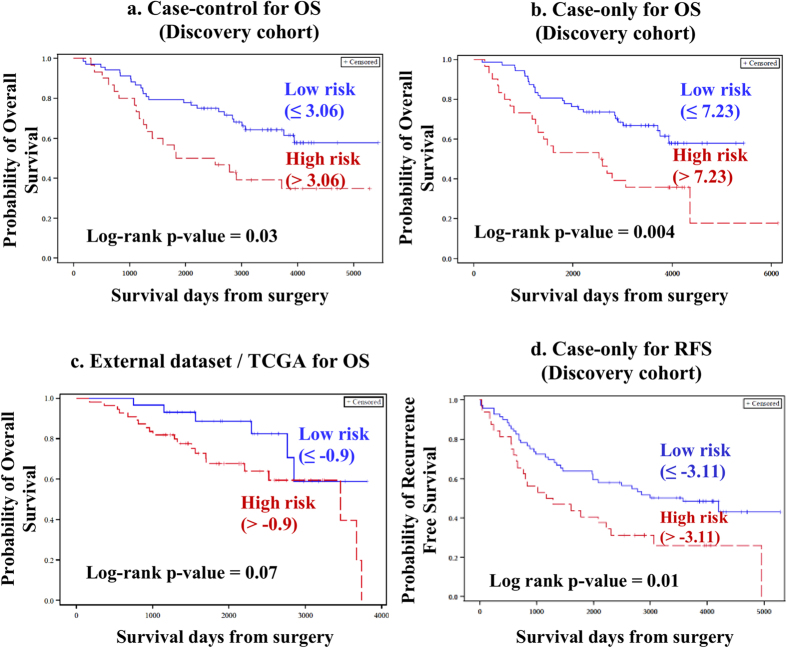
Kaplan-Meier plots for Overall Survival.Probability of OS is plotted over time and the Kaplan-Meier plots indicate that in both Case-control (a) and Case-only (b) approaches of discovery cohort, patients belonging to high-risk group are associated with poorer OS. A similar trend in survival pattern was observed in the external dataset/TCGA (c). (d) Probability of RFS is plotted over time and the Kaplan-Meier plots indicate that in the CO approach, patients belonging to high-risk group are associated with poorer RFS.